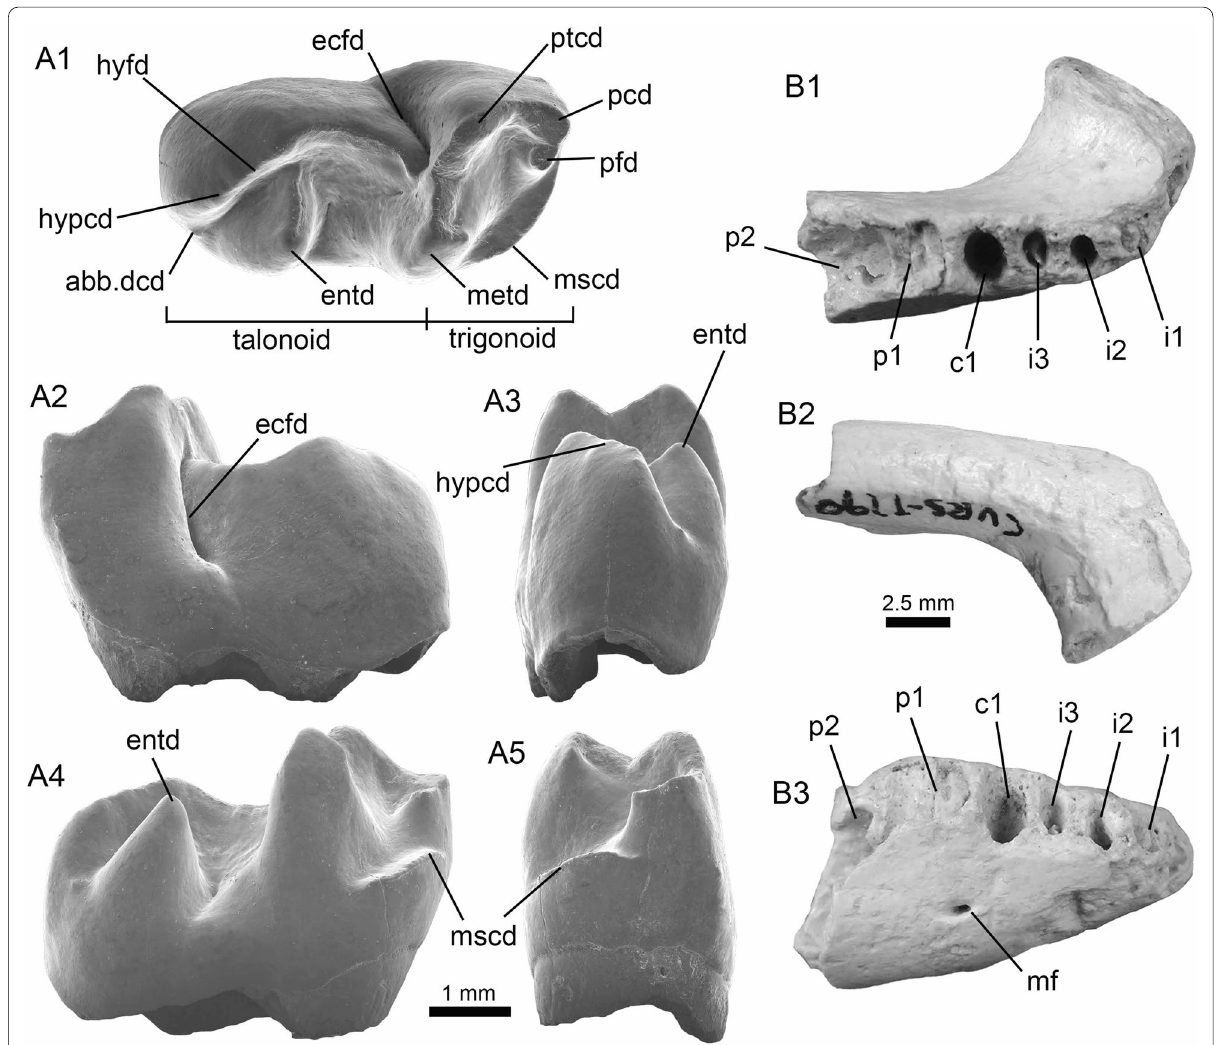
Fig. 26 Notoungulata (Typotheria) from the Vergel Member. A1 – A5 Left m3 (AMU‑CURS‑818) of Interatheriidae indet. B1 – B3 Jaw with fused symphysis (AMU‑CURS‑1190) of Typotheria inc. sed. Views: distal ( A3 ), dorsal ( B1 ), labial ( A2 ), lingual ( A4 ), mesial ( A5 ), occlusal ( A1 ), right lateral ( B3 ), and ventral ( B2 ). abb.dcd abbreviated distolingual cingulid, c canine, ecfd ectoflexid, entd entoconulid, hyfd hypoflexid, hypcd hypoconulid, i incisor, mf menthal foramen, metd metaconid, pcd paraconid, pfd paralophid, ptcd protoconid, p premolar, mscd mesiolingual